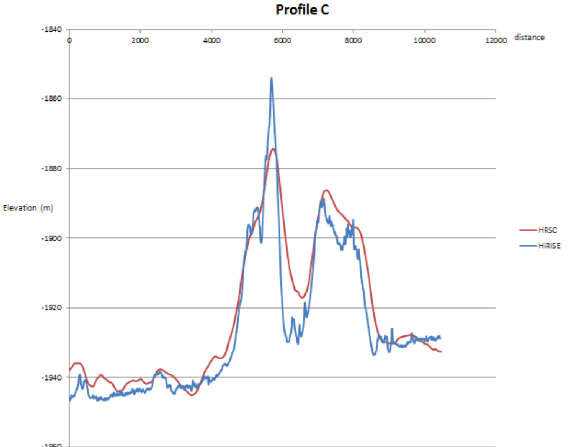
Figure 11. Profile C showing elevation of HiRISE (blue) and HRSC